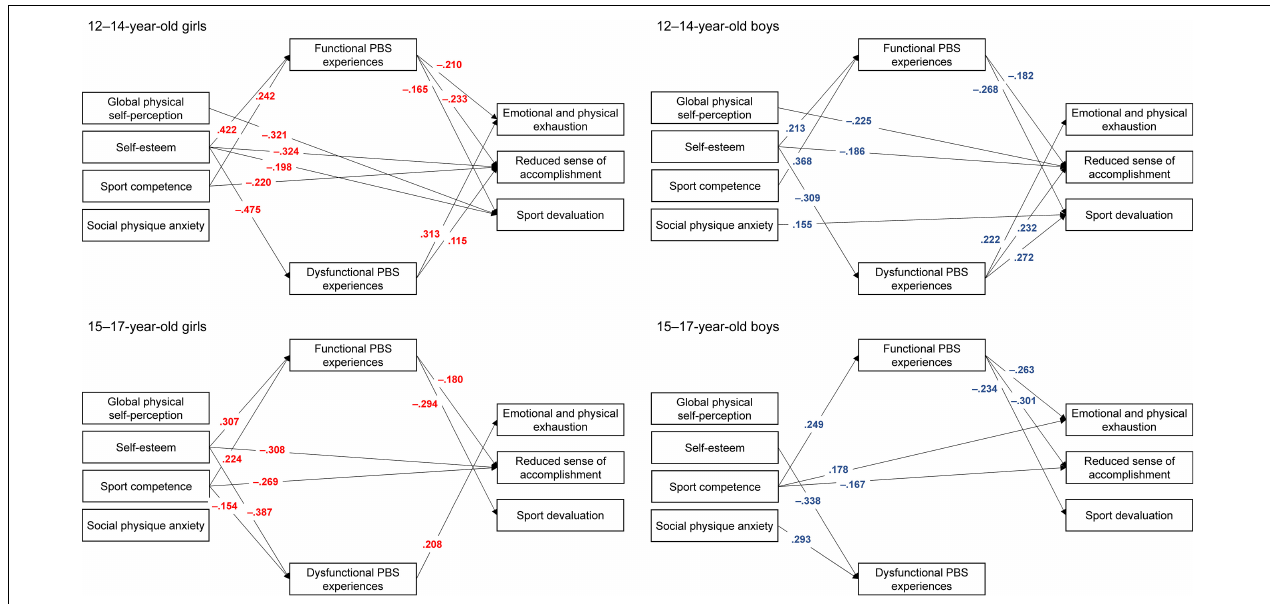
FIGURE 1 | Interrelationships between self-perceptions, psychobiosocial experiences and burnout across age and gender. Only significant standardized estimates are presented ( p <